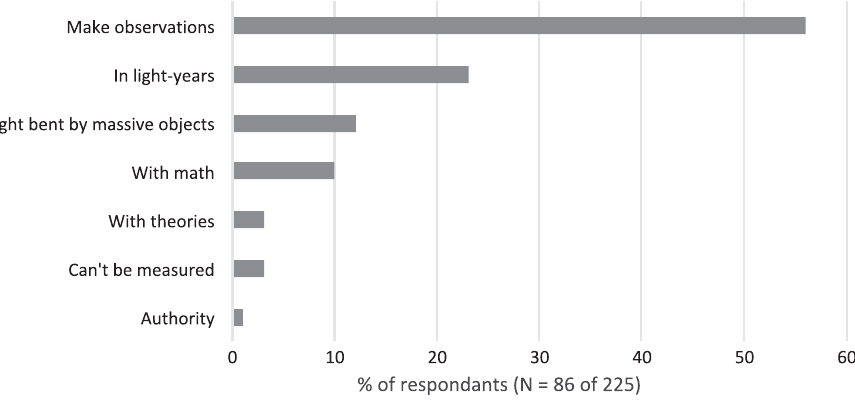
FIG. 8. ASTRO 101 Preinstruction survey responses for How do they measure this trait?